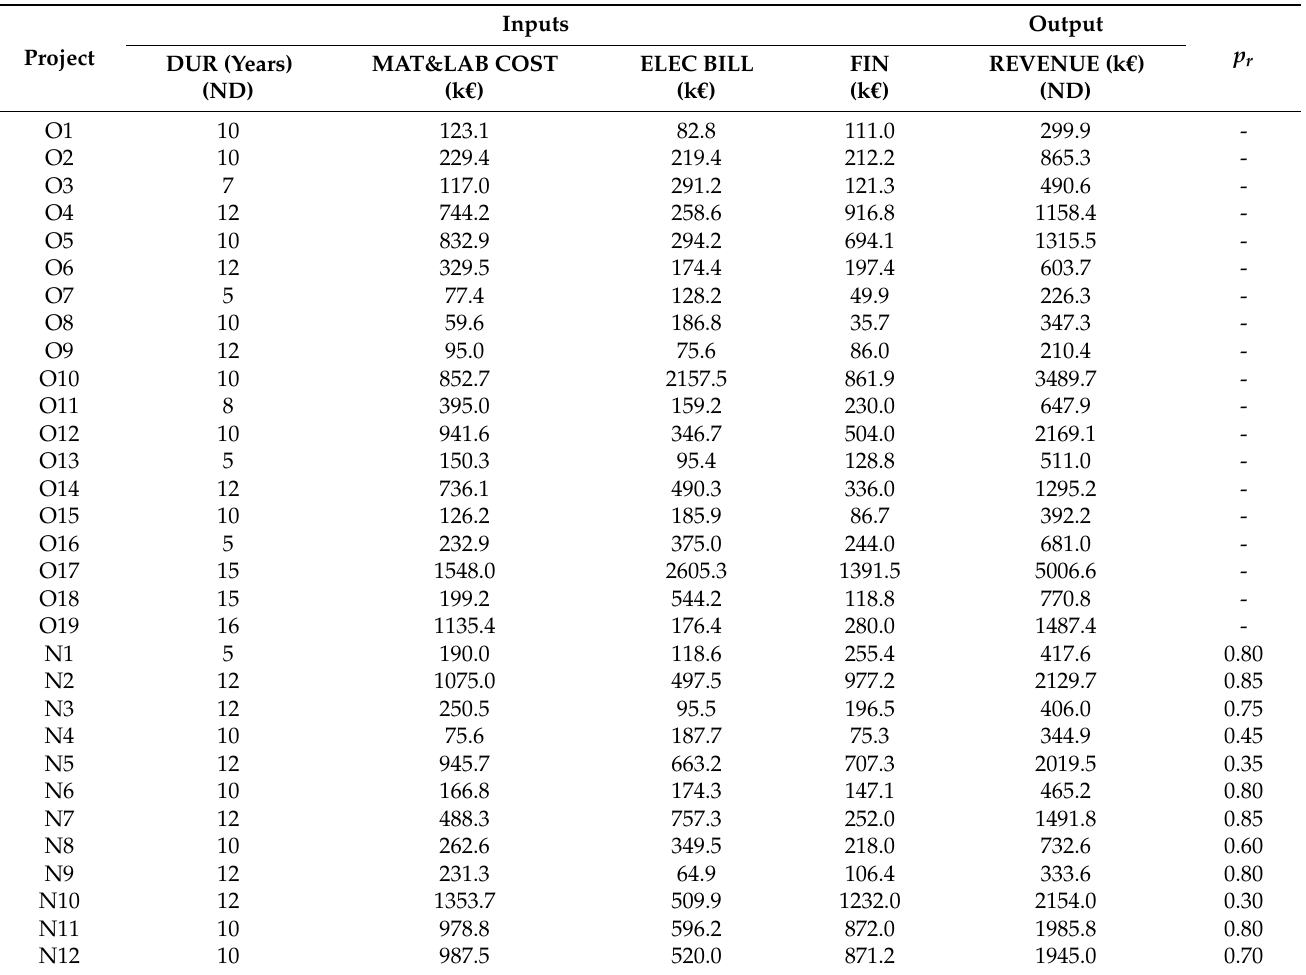
Table 1. Inputs, outputs of old and new projects; and probability of new projects. (ND = non-discretionary).